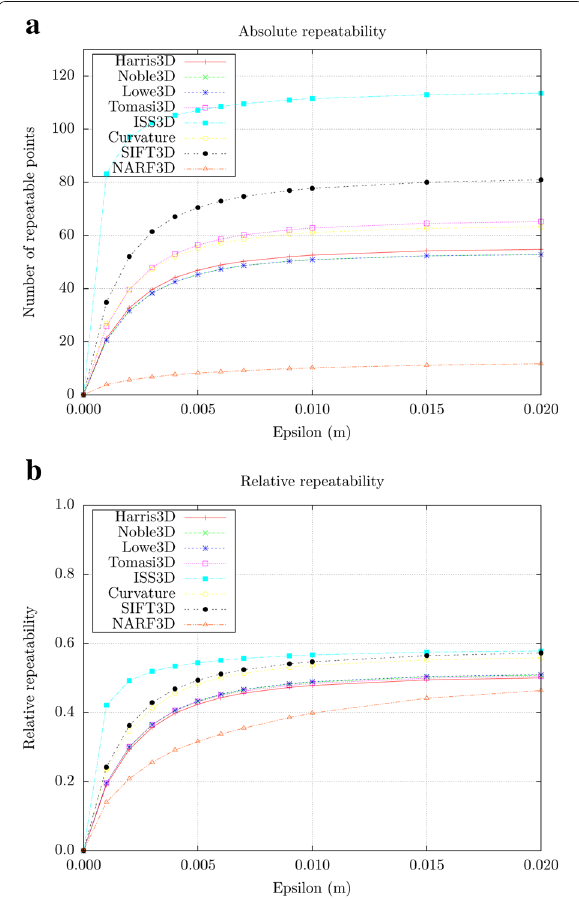
Fig. 9 a , b AFMA robot’s effector mounted with SR-4K camera and focussed on the object